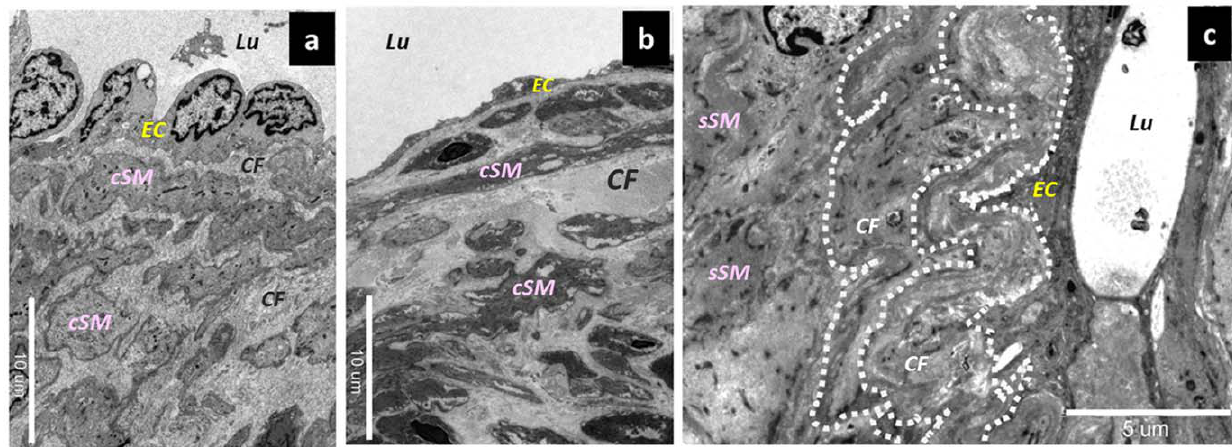
Figure 7. Changes affecting collagen fibers in collecting lymphatic vessels. (a) Collagen fibers in the normal type. Contractile smooth muscle cells and collagen fibers were mixed together in the medial layer. Bar=10 m m. (b) Collagen fibers in the ectasis type. The dilation of the lymphatic vessel was accompanied by an elongation of collagen fibers, causing the slightly thickened aspect. Bar=10 m m. (c) Collagen fibers in the contraction type. Once the collagen fibers were elongated, they became multilayered and tortuous (dotted line), in association with the hypertrophy of the walls of the collecting lymphatic vessels. Bar=5 m m. EC; endothelium cells, seSM; synthetic smooth muscle cells, sySM; synthetic smooth muscle cells, cSM; contractile smooth muscle cells, CF; collagen fibers.